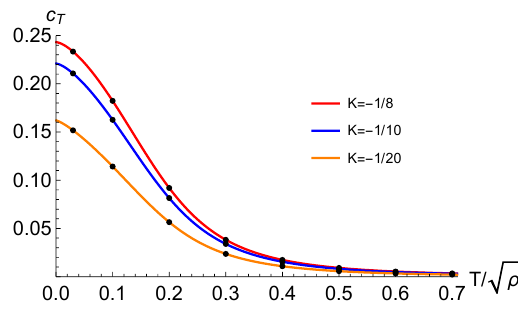
Figure 3 . Real and imaginary parts of the lowest QNMs for different couplings K . We have fixed √ T/ ρ = 0 . 2 and λ = 0 .